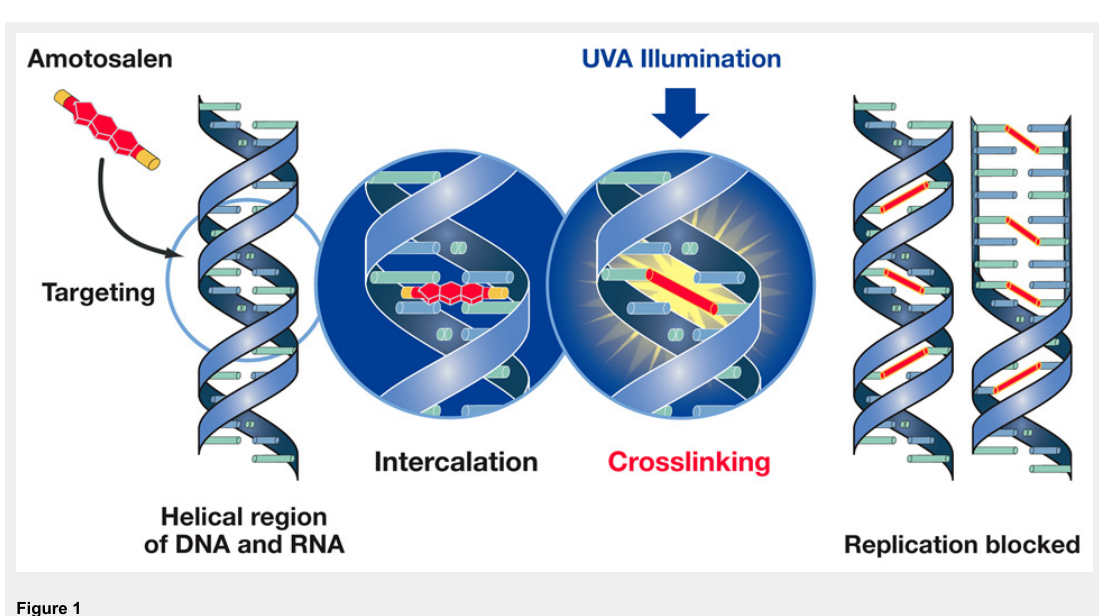
Pathogen reduction with the INTERCEPT ® method. Schematic representation of the mode of action of INTERCEPT ® . Amotosalen intercalates within DNA/RNA. DNA/RNA crosslinks upon UVA irradiation. This blocks reproduction of pathogens and leucocytes. Courtesy of Cerus Corporation, Concord, CA, USA.